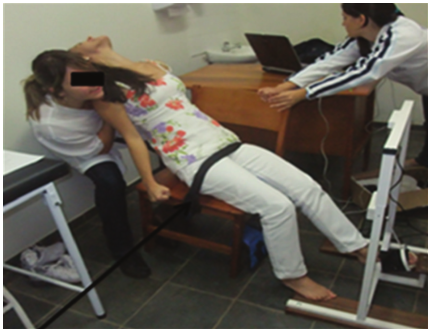
Figure 5: Trunk extension